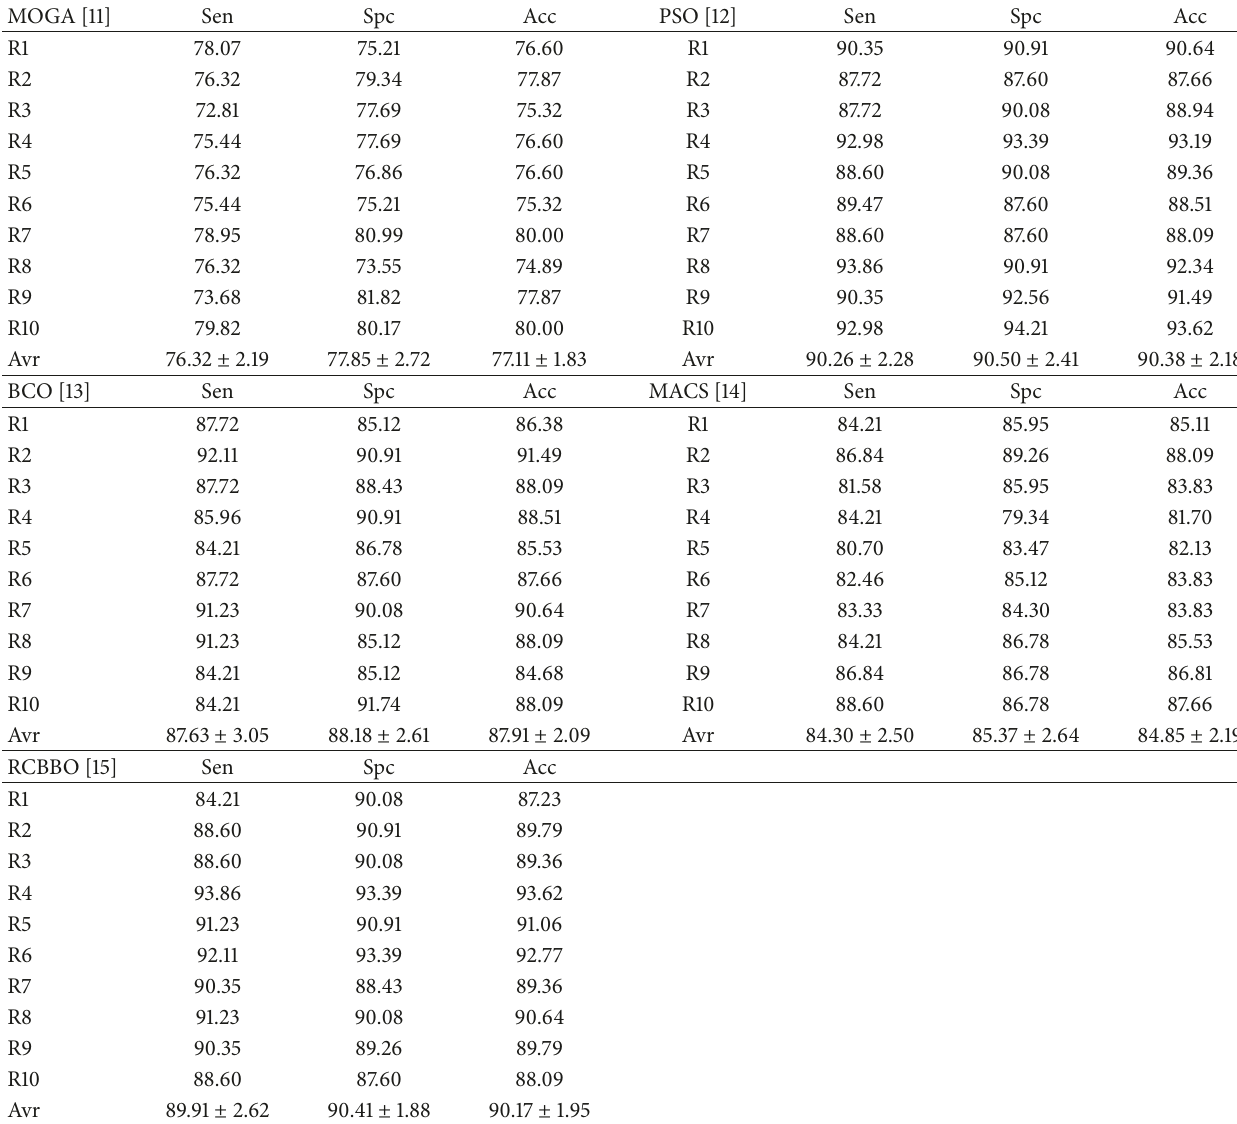
Table 10: Results of 10 × 10-fold cross validation of four training algorithms.